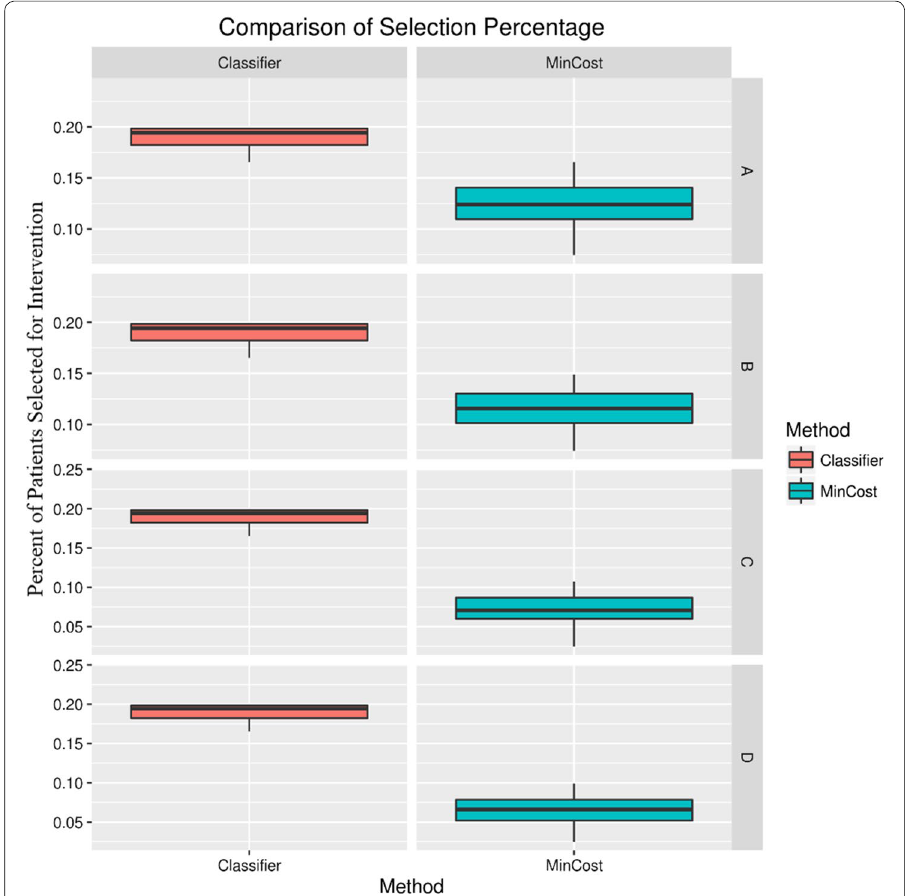
Fig. 5 Comparison of MinCost and binary classification patient selection percentage for each assumption